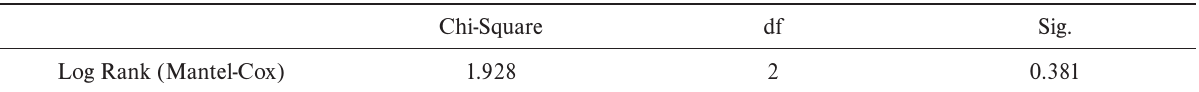
Table 4. Test of equality of survival distributions for the different levels of patient subgroups according to inducibility.